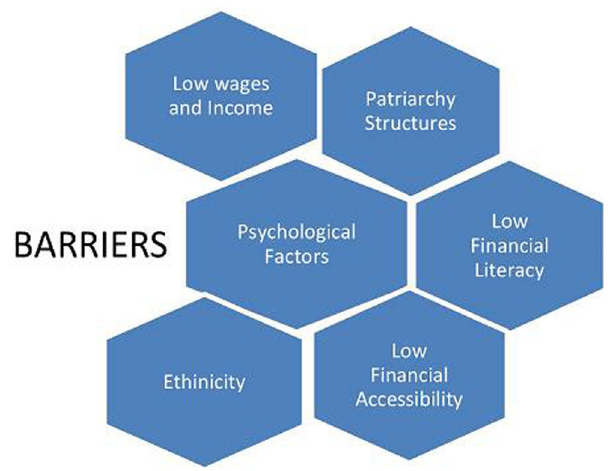
Fig. 3 Important barriers to FI of women. Six cyclic and interconnected barriers to the FI of women identi fi ed through an expert evaluation of selected studies (author